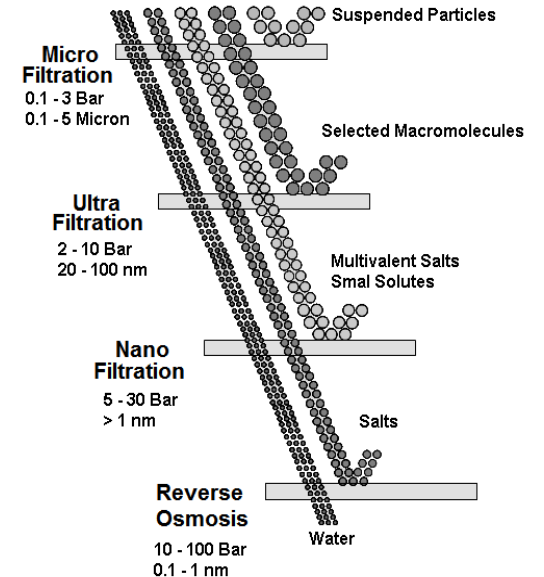
Figure 1. Reverse-osmosis membrane size and its selectivity rather than other membrane work